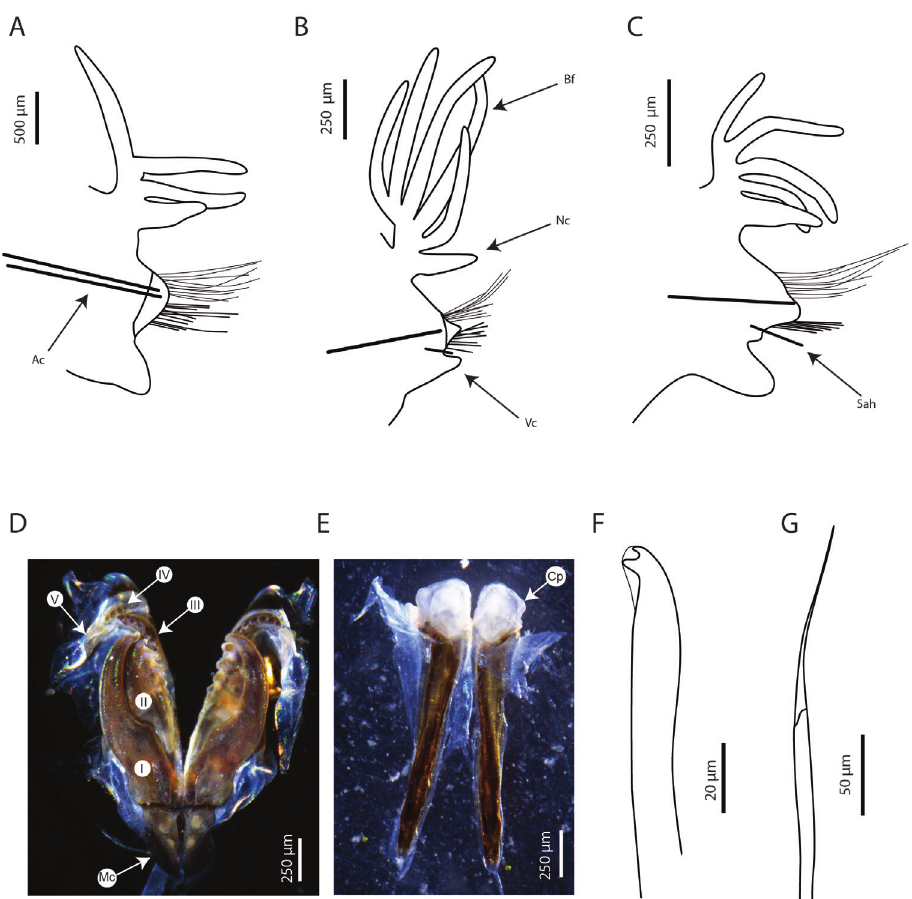
Figure 3. Marphysa banana sp. nov. holotype MNHN-IA-2015-1608 ( A–C, F–G ), paratype MNHN- IA-2021-725 ( D, E ): A parapodia from anterior chaetiger (chaetiger 29) B parapodia from mid-body (chaetiger 100) C parapodia from posterior chaetiger (chaetiger 190) D maxilla, dorsal view E mandibles, dorsal view F subacicular hook from mid-body (chaetiger 100) G spiniger from chaetiger 29. Abbrevia- tions: MI to MV, maxillae I to V; Ac, aciculae; Bf, branchial filament; Cp, cutting plate; Mc, maxillary carrier; Nc, notopodial cirri; Sah, subacicular hook; Vc, ventral cirri. A–C Sah and Ac are illustrated schematically to indicate